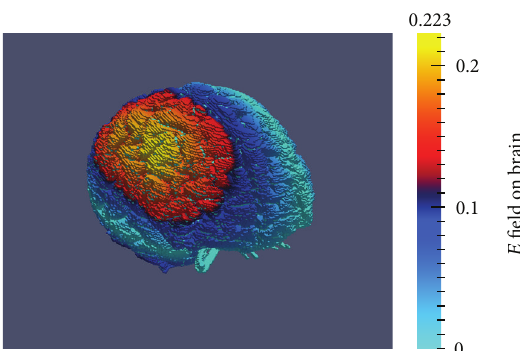
Figure 10: The total electric field distribution on